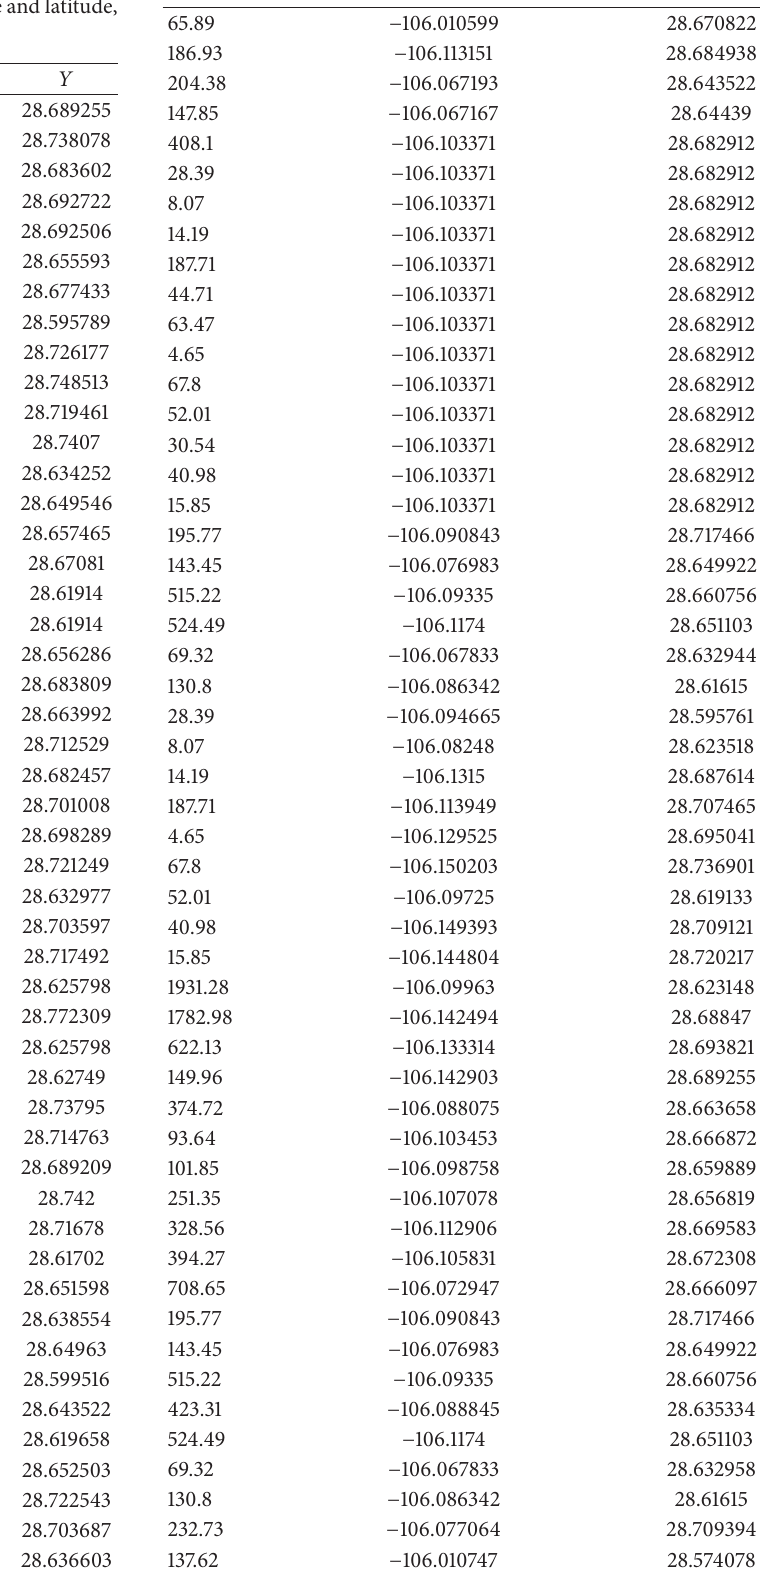
Table 6: Radon concentration values (RC), in Bqm − 3 , obtained by measurements in random selected dwellings at Chihuahua City, Chihuahua, Mexico. 𝑋 and 𝑌 are geographic longitude and latitude,